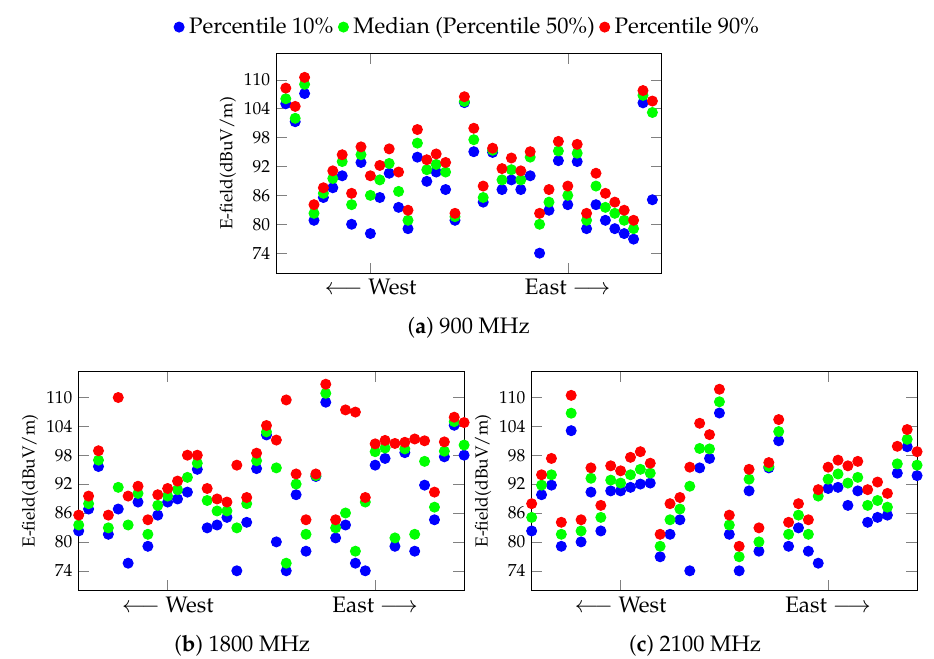
Figure 13. Spatial diversity of measurement among the dosimeters for each frequency band. Each point represents a percentile of the values obtained by one dosimeter during the year 2016. The X-axis indicates the geographical location of the dosimeter, so that the lower the x -value, the more east the location is.